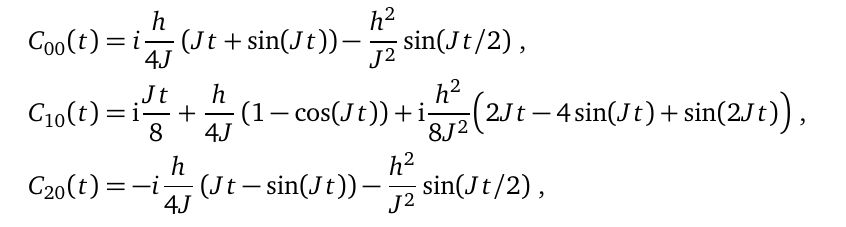
Figure 7: Next-nearest-neighbor correlation function in d = 1 obtained with first-order and second-order cumulant expansion in comparison with the exact result; h / J =